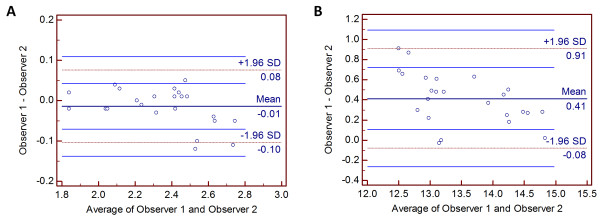
Bland-Altman plots for observer 1 and observer 2 comparing measurements of anterior chamber depth (A) and anterior chamber width (B). The horizontal lines represent the mean and 95% limit of agreement (LoA).